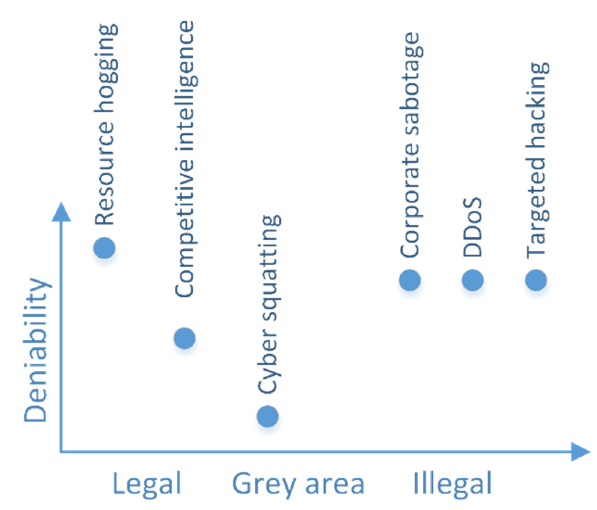
Figure 2. Illustrating the legality and deniability of different competitor actions (not to any scale).